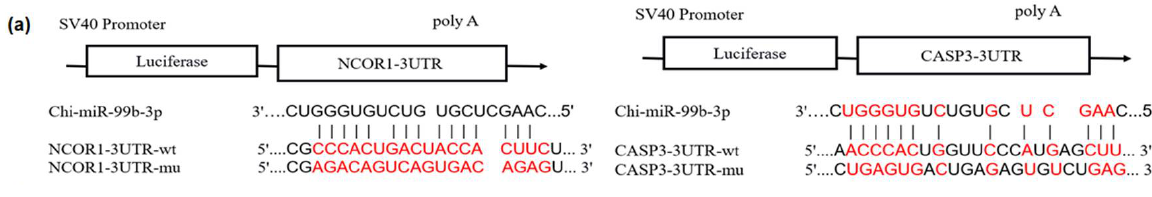
Figure 2. Caspase-3 and NCOR1 are the target genes of chi-miR-99b-3p. ( a ) Diagram depicting the binding sites of chi-miR-99b-3p on the 3'-UTR of Caspase-3 and NCOR1 (highlighted in red). ( b ) De- tection of relative luciferase activity. wt, wild-type. mut, mutant-type. All results are presented as means ± SEM. n = 3. * p < 0.05; ** p < 0.01. ( c ) Overexpression or suppression of chi-miR-99b-3p impacted the expressions of Caspase - 3 and NCOR1 at the mRNA level.